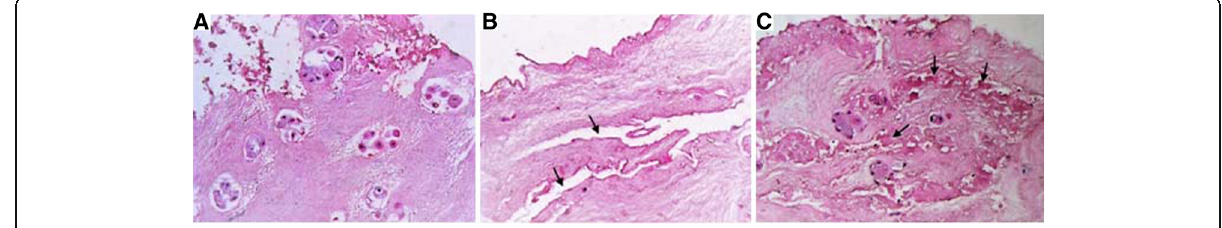
Fig. 2 Hematoxylin and eosin-stained sections (original magnification × 200). a Chondrocyte proliferation with multiple chondrocytes growing in sharply demarcated small rounded clusters. b Structural alterations with concentric tears (arrows) following the collagen fiber bundle orientation in the annulus fibrosus. c Granular changes (arrows) with eosinophilic-staining amorphous granules within the fibrocartilage